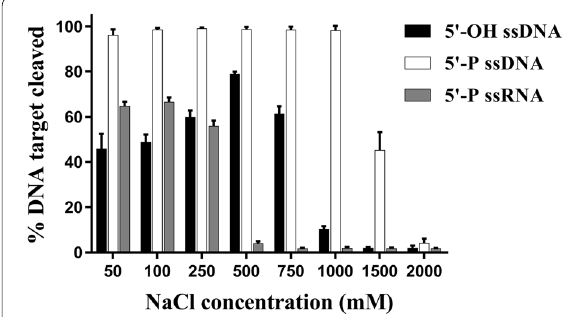
Fig. 6 Effect of NaCl on the enzyme activity of Mf Ago. Error bars represent the SDs of three independent